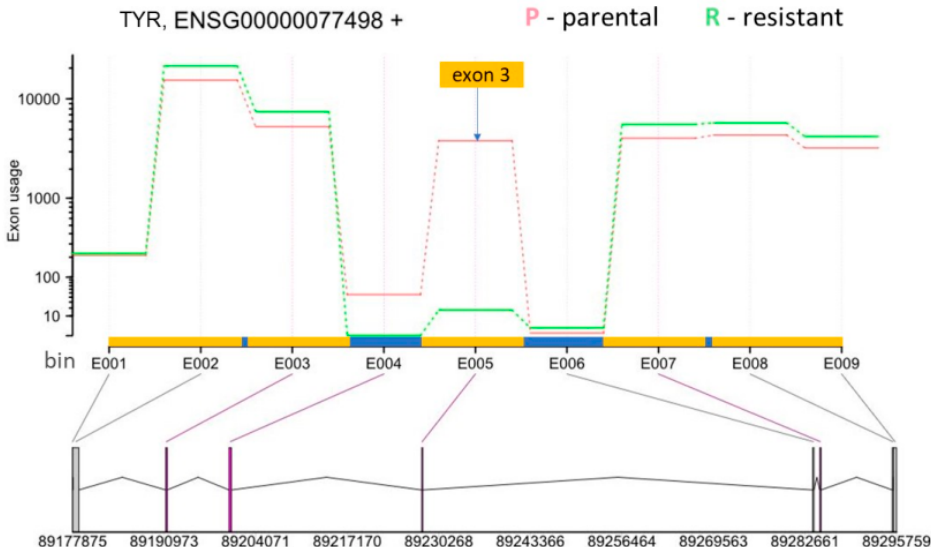
Figure 6. DEXSeq results for TYR (Ensembl gene ID: ENSG00000077498). The y -axis shows the exon usage (normalised counts corrected for gene-expression) in parental (P) and resistant (R) cells for each exon bin annotated for the plus strand ( x -axis). Exon bins (E001, . . . ) are sections of the genome that correspond to whole exons or exon fragments in the gene model, as indicated by the grey lines. X-axis is also demarcated for the gene model with exons (yellow boxes) and introns (blue boxes), with exon one starting at the bin number E001 and exon 5 ending at the bin number E009. Below the x -axis the gene model is shown with numbers indicating genomic coordinates. Boxes represent exons. Horizontal lines represent introns. The vertical or diagonal lines indicate the position of the exon bins in the gene model. Purple lines indicate statistically significant bin usage. The position of the skipped exon 3 in the resistant cells is indicated by yellow box and the arrow.